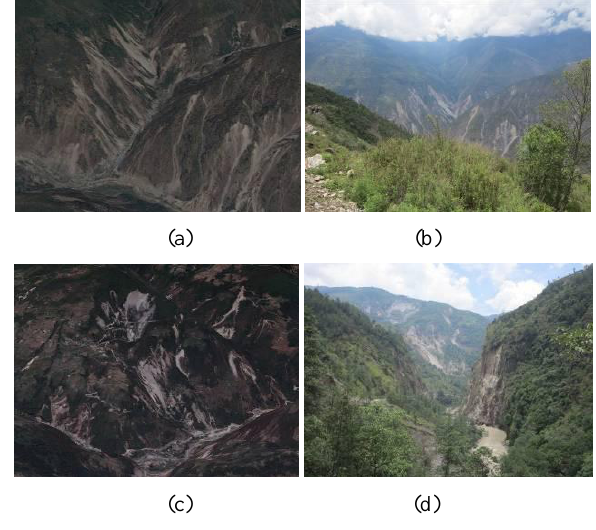
Figure 4. Comparisons of coseismic landslides on satellite images and field photos. (a) Satellite image of 3 May 2015 from Google Earth platform. (b) Field photo of 15 June 2015. (c) Satellite image of 25 May 2015 from Google Earth platform. (d) Field photo of 14 June 2015. (a) and (b), (c) and (d) show the same scenes at the Pasang Lhamu Highway and the Araniko Highway, respectively.